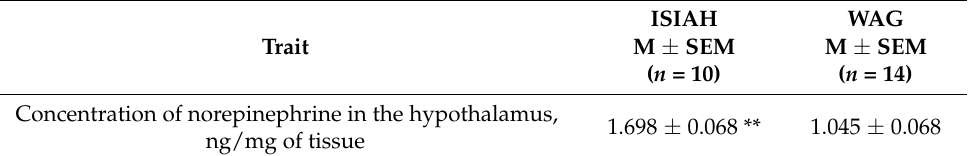
Table 1. Comparative characteristics of Inherited Stress-Induced Arterial Hypertension (ISIAH) and Wistar Albino Glaxo (WAG) rats aged 6 months. Trait Concentration of norepinephrine in the hypothalamus, ng/mg of tissue